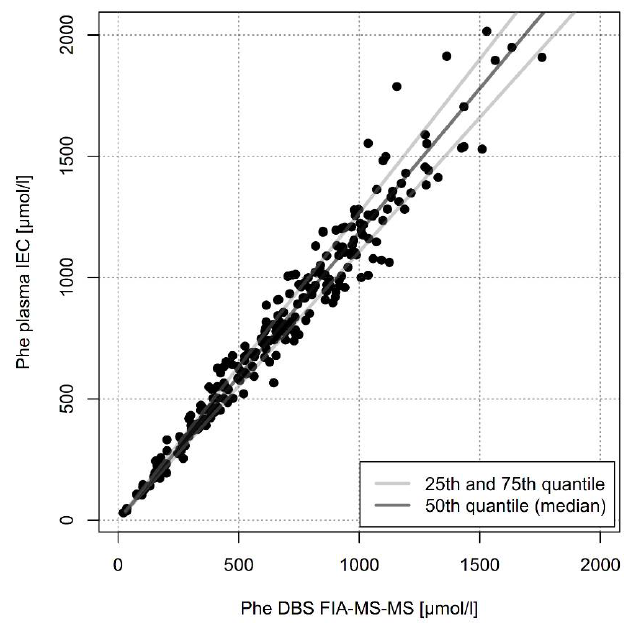
Figure 5. Comparison of DBS Phe concentration measured by FIA-MS-MS with plasma Phe concentration measured by IEC in 240 paired DBS and plasma specimen. The dark line represents the 50th quantile (median), the lighther lines the 25th and the 75th quantiles.